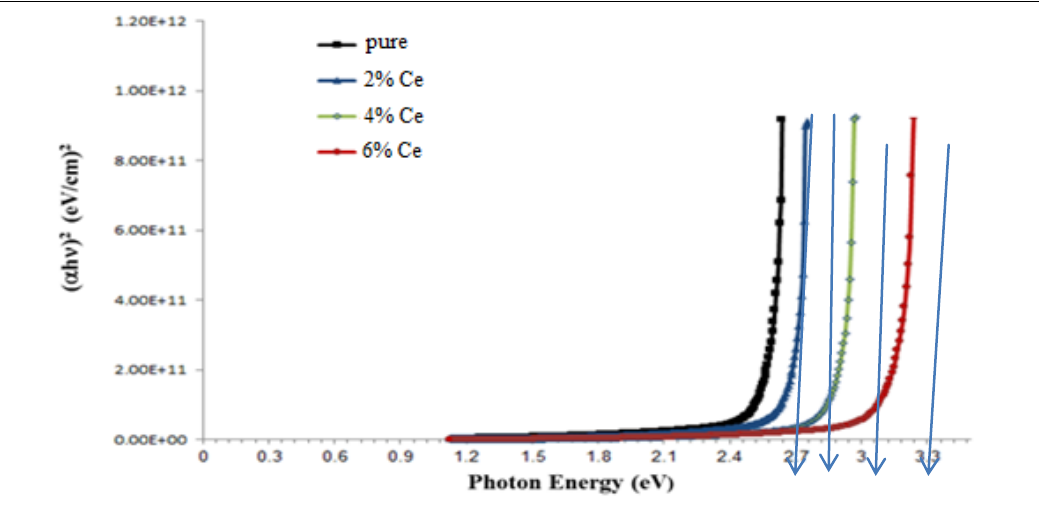
Fig. 12: Variation of absorption coefficient as a function of wavelength for CdO films at different concentration of Ce.